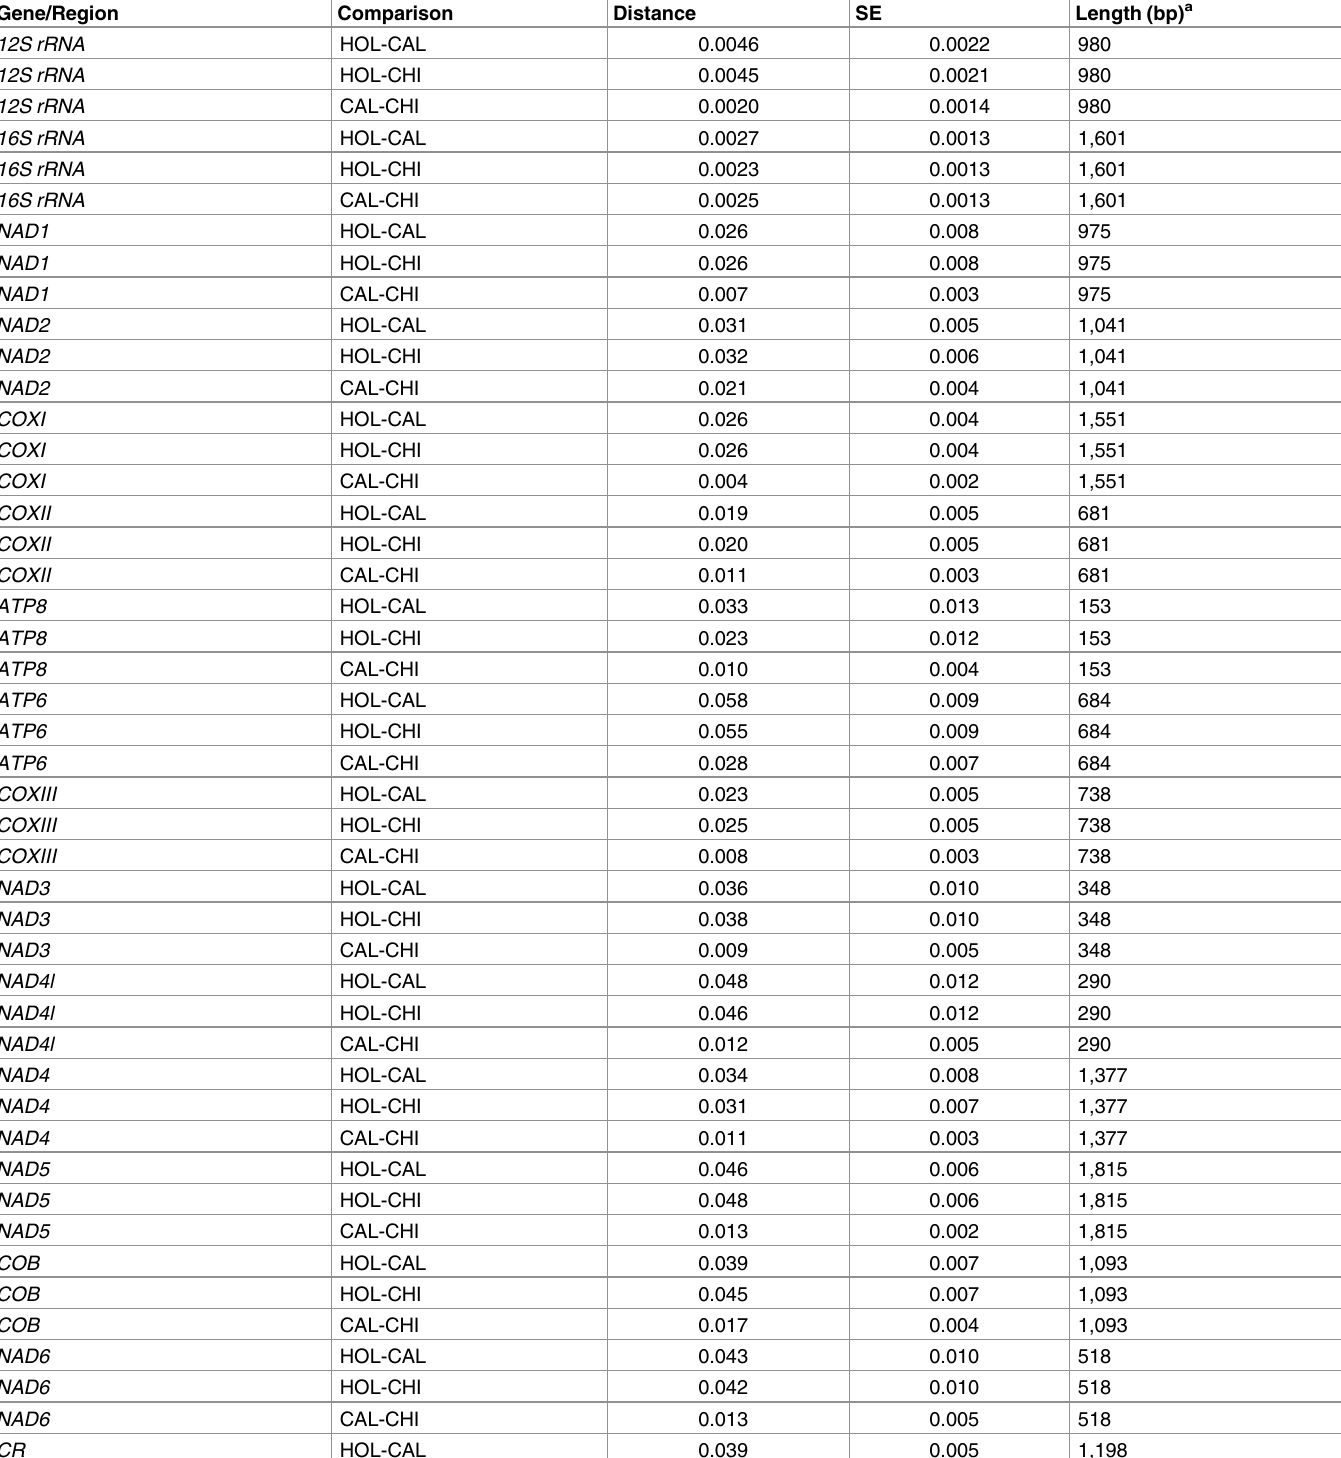
Table 2. Genetic distances (uncorrectedp-distances) among Holarctic (HOL) and Californian (CAL) lineages of the common ravenand the Chihua- huan (CHI) raven, for different partitions, the whole alignment and protein coding genes concatenated.